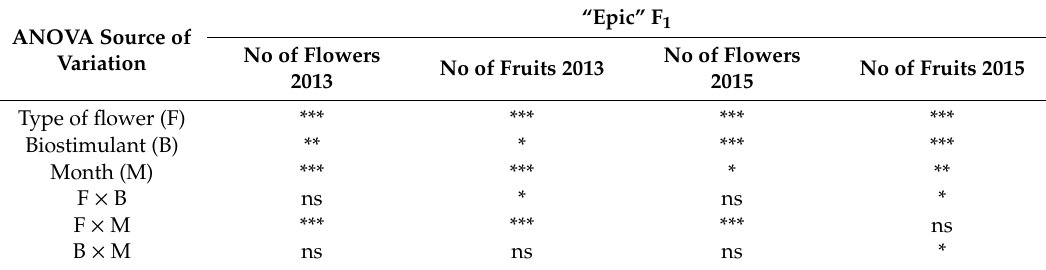
Figure 4. The course of flowering and fruit setting of “ Epic ” F 1 eggplant as depended on fruit type and biostimulant treatment. C, control; B, biostimulant. Bars represent mean number of flowers per plant in 2013 ( a ), 2015 ( b ) and fruits per plant in 2013 ( c ), and 2015 ( d ) (error bars indicate SE). Table 3. Results of ANOVA for parameters of flowering and fruit setting of “Epic” F 1 eggplant presented in Figure 4.